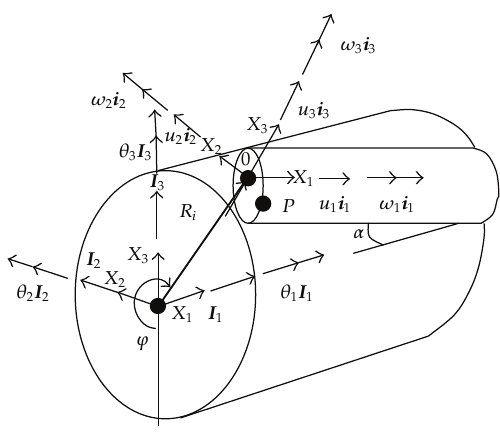
Figure 2: Coordinate